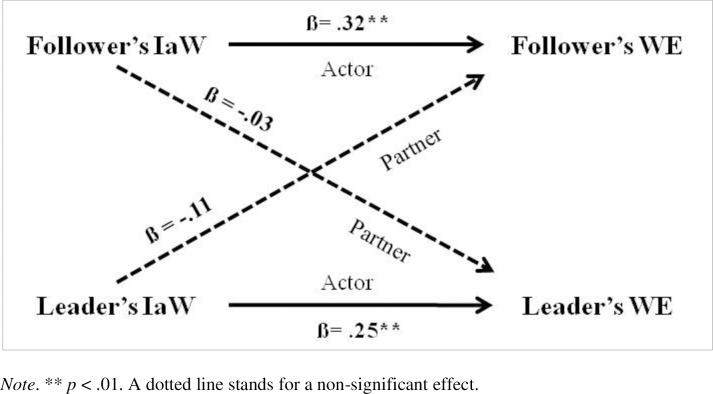
APIM with distinguishable dyads: Independence at Work (IaW) on Work Engagement (WE).